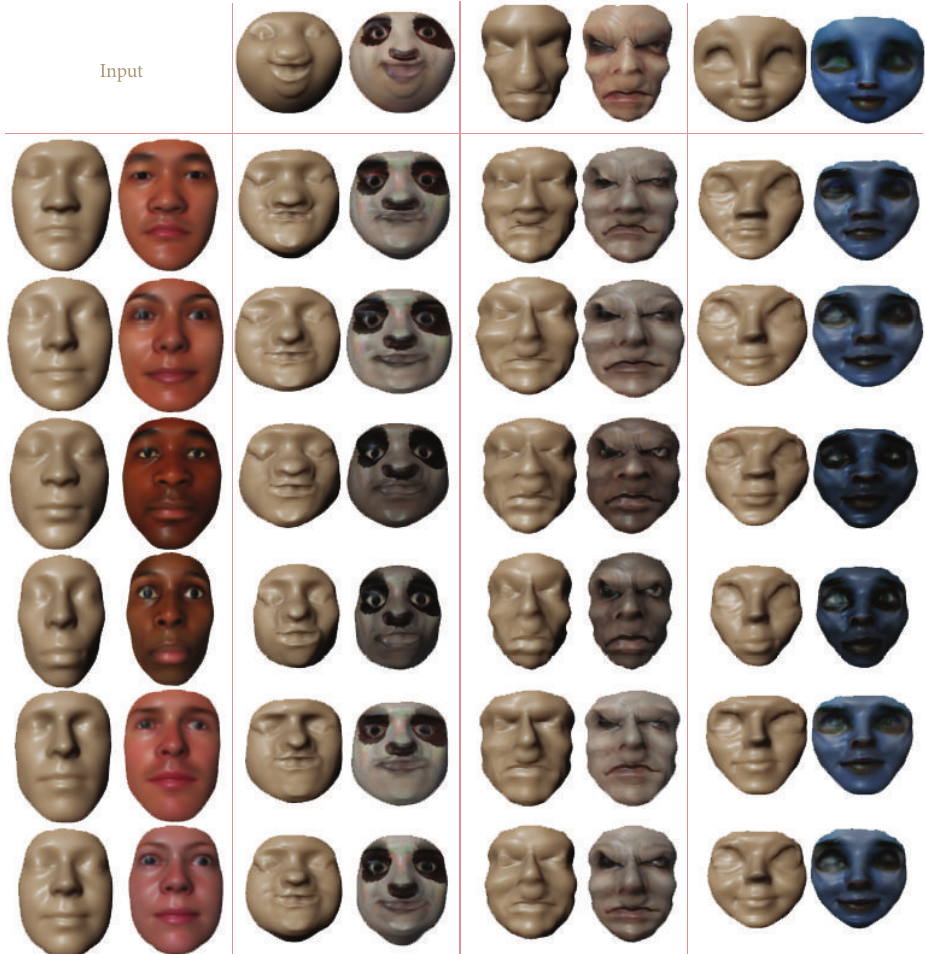
Figure 10: The second group of example results by our approach. The leftmost column shows the input HI-faces. The top row shows the input AS-faces.